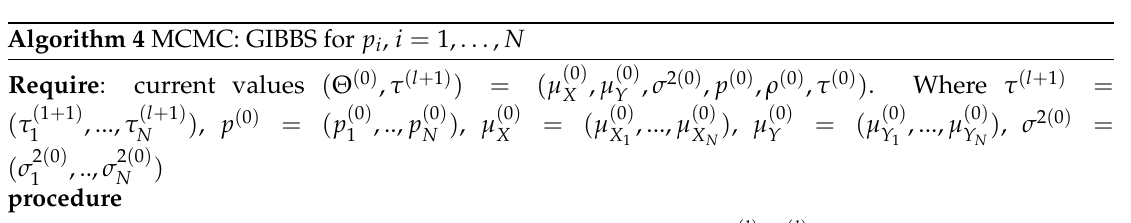
Algorithm 4 MCMC: GIBBS for p i , i = 1, . . . ,